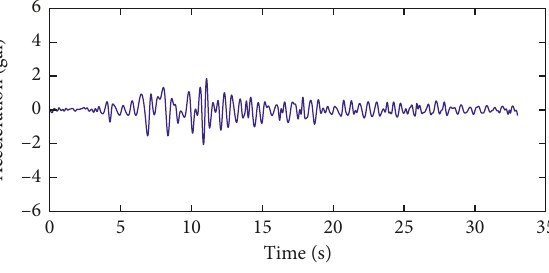
Figure 11: EEMD denoising result.